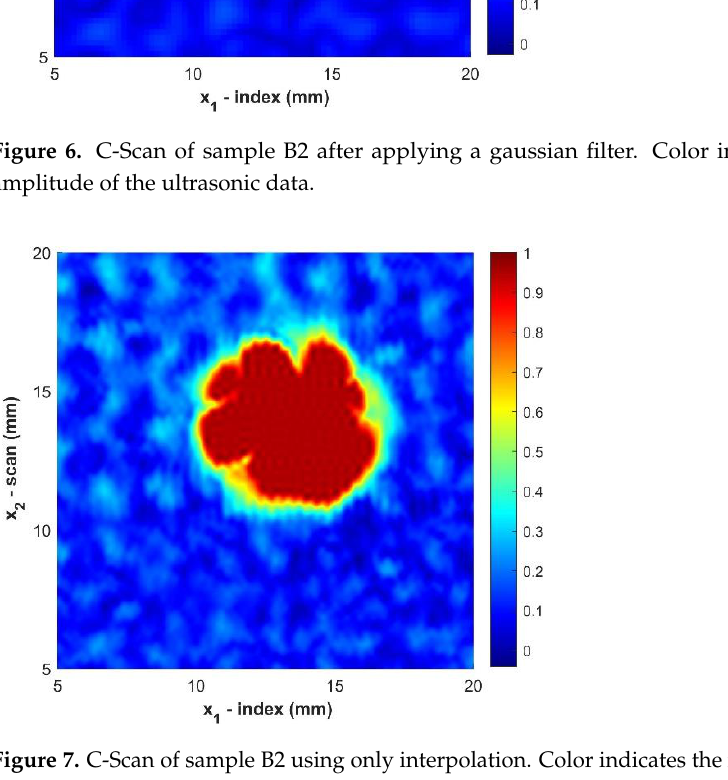
Figure 8. C-Scan of sample B2 after applying both smoothing and interpolation. Color indicates the normalized amplitude of the ultrasonic data. 3.3. Use of Gradient for Edge Detection Even with the improvement of the c-scan image it is still difficult to determine the boundary of the inclusion. Edge detection is fundamental to image analysis and simple edge detection can be accomplished using a derivative [32]. The magnitude of the gradient of 𝐻(𝑥 1 , 𝑥 2 ) is used in this work to perform a two-dimensional edge detection and is given as